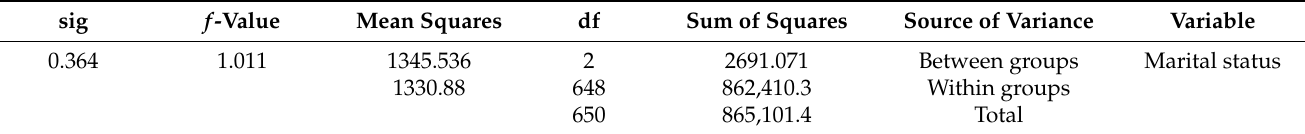
Table 4. ANOVA for differences in anxiety about COVID-19 infection by social status. sig f -Value Mean Squares df Sum of Squares Source of Variance Variable